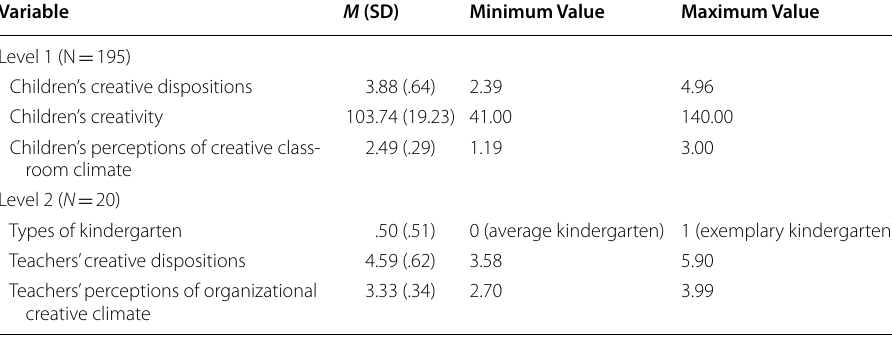
Table 3 Descriptive statistics of child-level variables and teacher-level variables Variable M